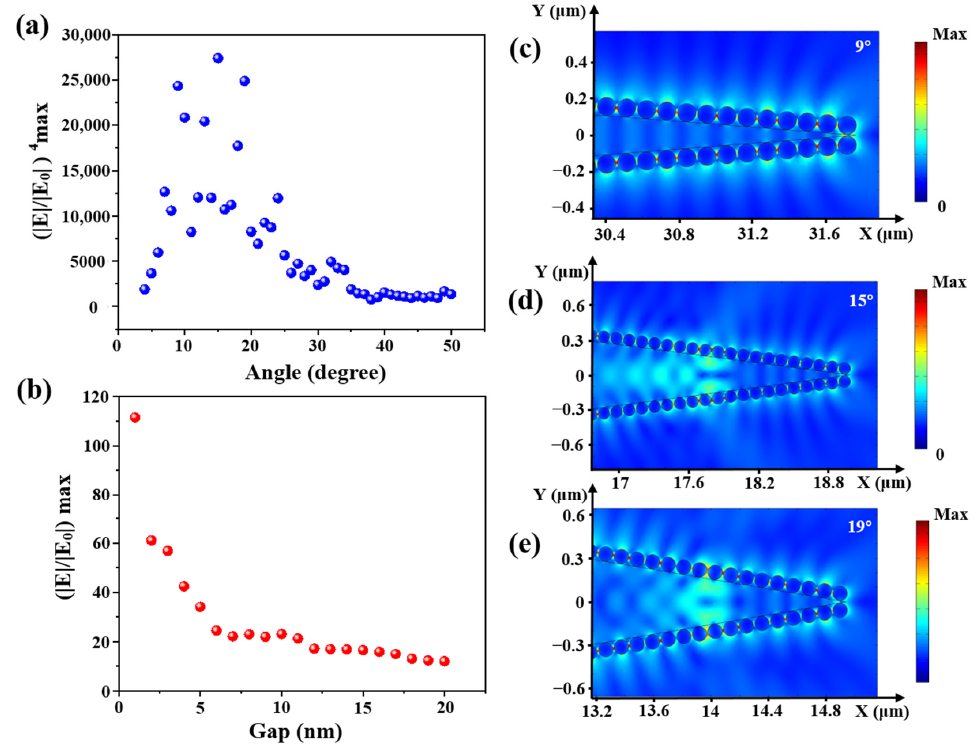
Figures 8 Figure 7. ( a ) The relationship between (|E|/|E 0 | 4 ) max and the cone angle; ( b ) the relationship between |E|/|E 0 |max and the gap between two AgNPs and the electric field distribution with cone angles of ( c ) 9 ◦ , ( d ) 15 ◦ and ( e ) 19 ◦